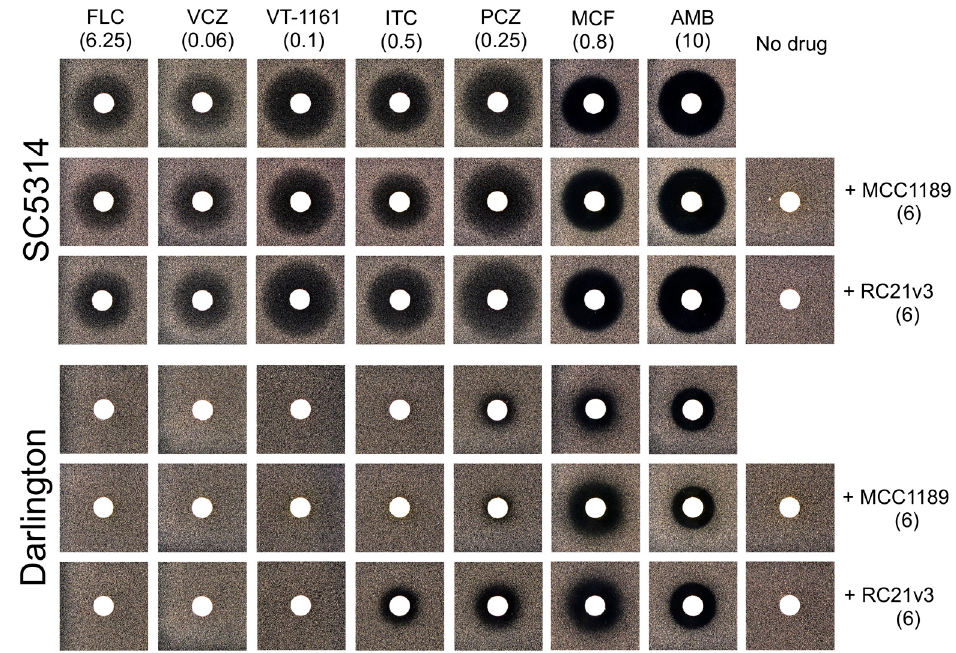
Figure 3. Agarose diffusion analysis of the interaction of control and azole drugs with wild-type C. albicans (SC5314), and the Darlington strain. The values in parentheses represent drug loadings in nanomoles.